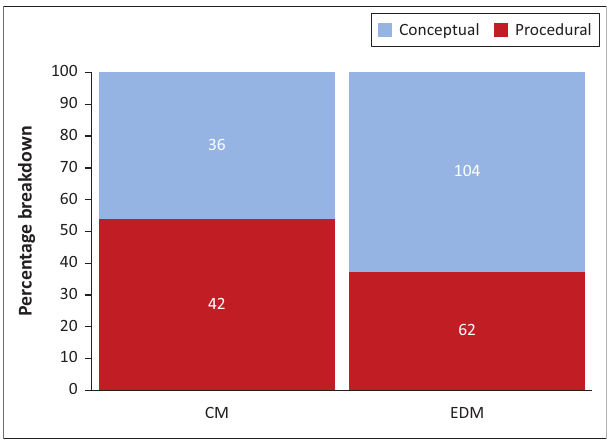
FIGURE 2: Comparison of blocks that promote procedural and conceptual knowledge in Classroom Mathematics Grade 9 and Elemente der Mathematik 3 . The number of blocks coded in each category per book is also